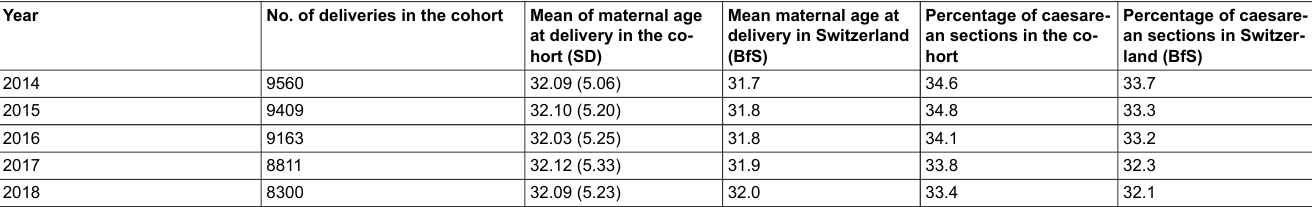
Table S2: Exposure to potentially teratogenic or fetotoxic drugs during risk period and associated potential risks (crude numbers). Potentially teratogenic or fetotoxic drugs (ATC code)